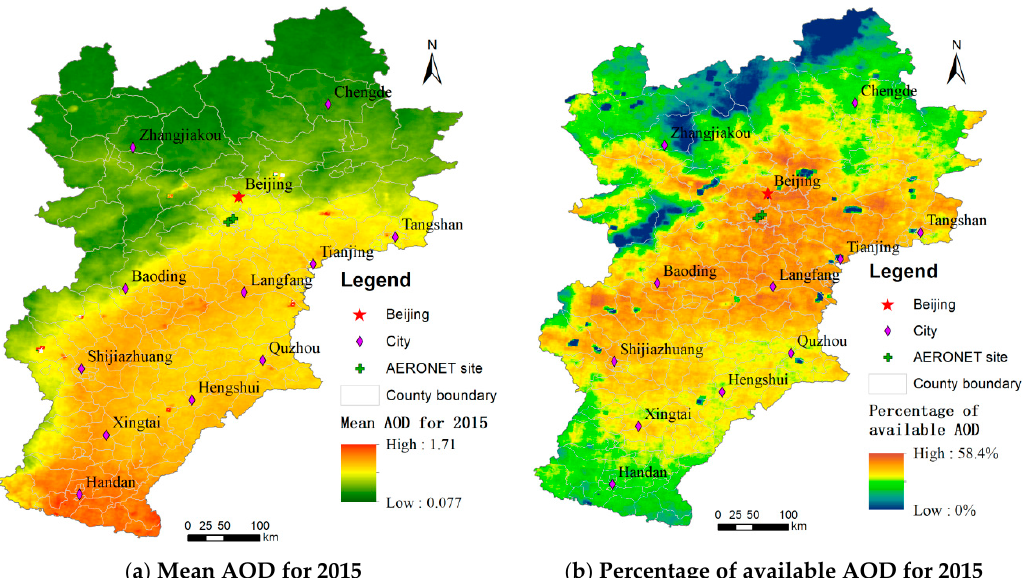
Figure 4. Statistics (( a ) mean AOD; ( b ) percentage of available AOD) for 2015 MAIAC AOD of the study region.